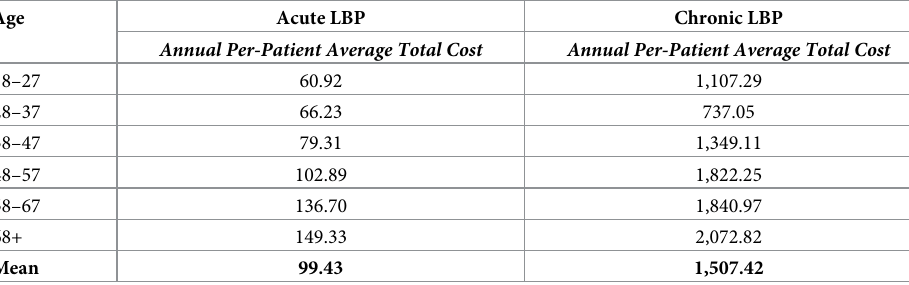
Table 6. Per-patient average total cost for acute and chronic